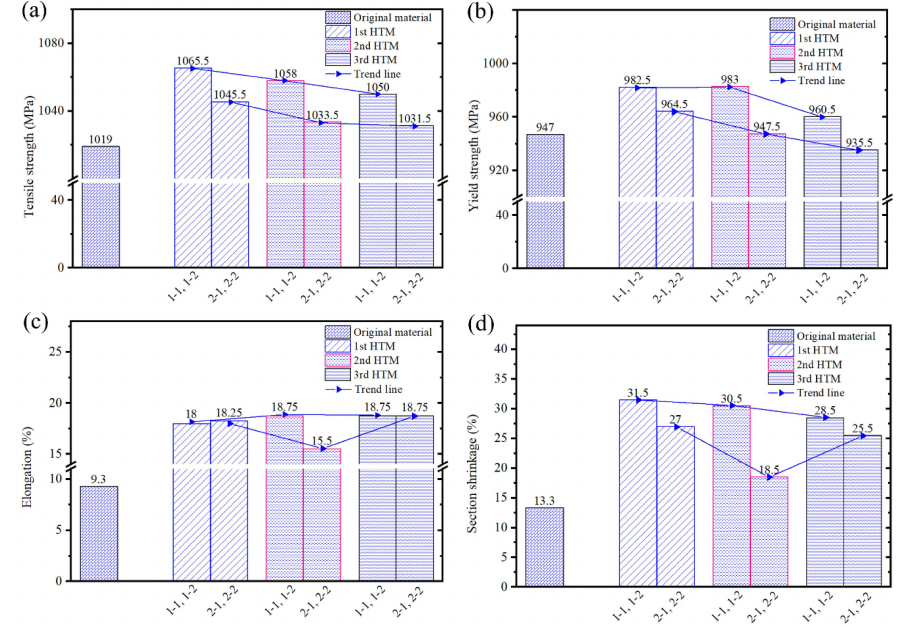
Figure 17. Mechanical properties of tensile specimens at room temperature: ( a ) the tensile strength, ( b ) the yield strength, ( c ) the elongation, and ( d ) the section